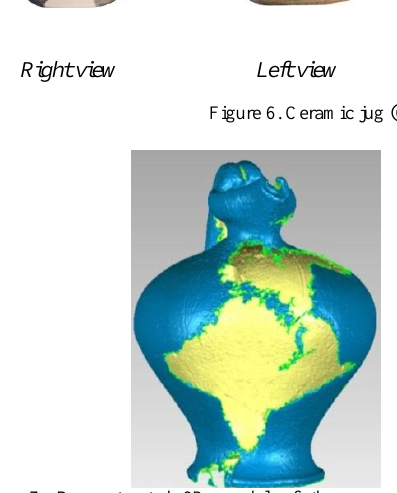
Figure 7: Reconstructed 3D model of the ceramic jug: the white textureless part was not reconstructed using a standard photographic equipment and photogrammetric